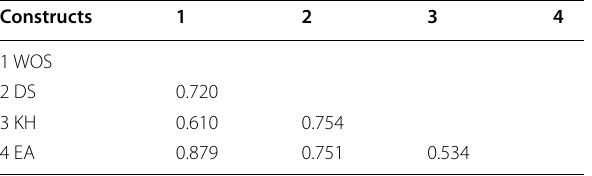
Table 5 Discriminant validity (HTMT